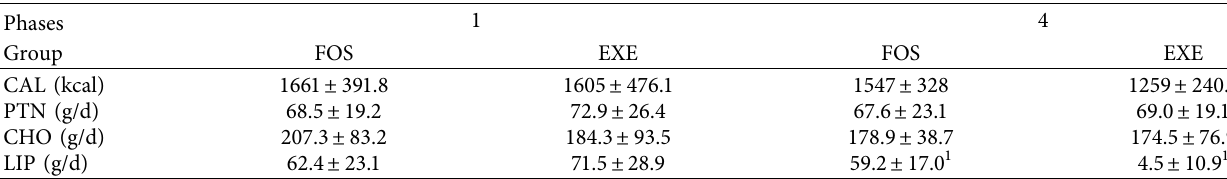
Table 3: Average caloric intake